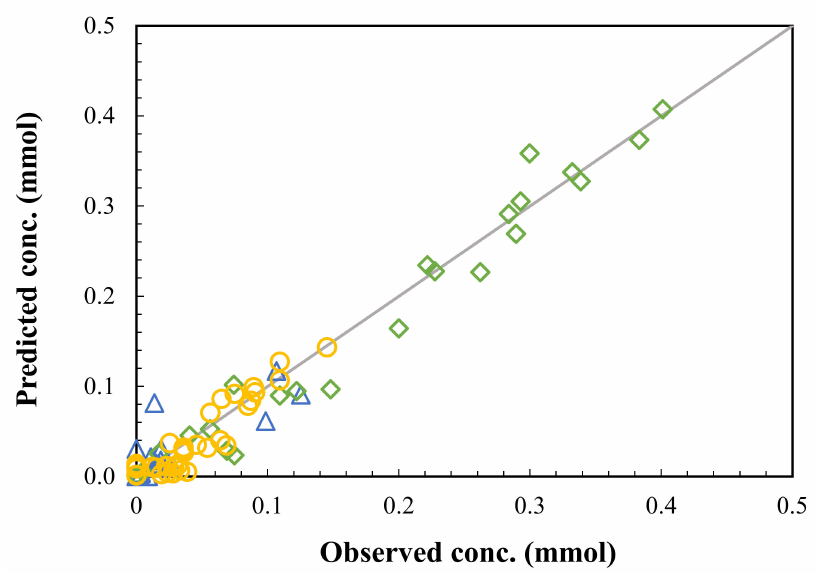
Figure 2. Parity diagram for all experimental and simulated points of fructose dehydration carried out under CH and MW conditions. ( ∆ ) stands for fructose conversion, (o) denotes LA + FA, and ( (cid:3) ) denotes